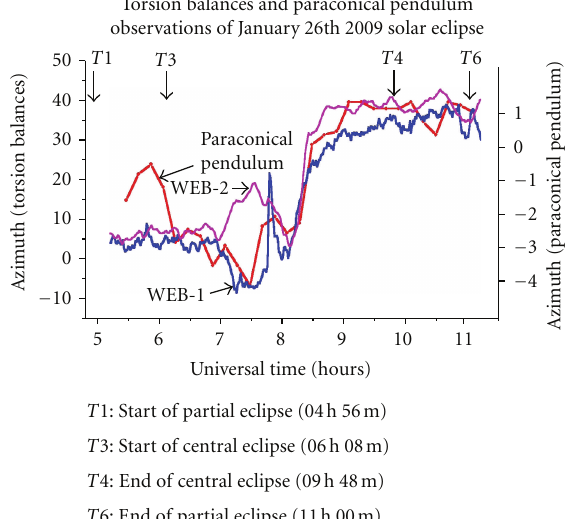
Figure 9: Comparison of the results of observations in Kiev (blue and purple) with observations in Suceava (red line). In order to align the curves, the graph for the PP is shifted forward by 1.59